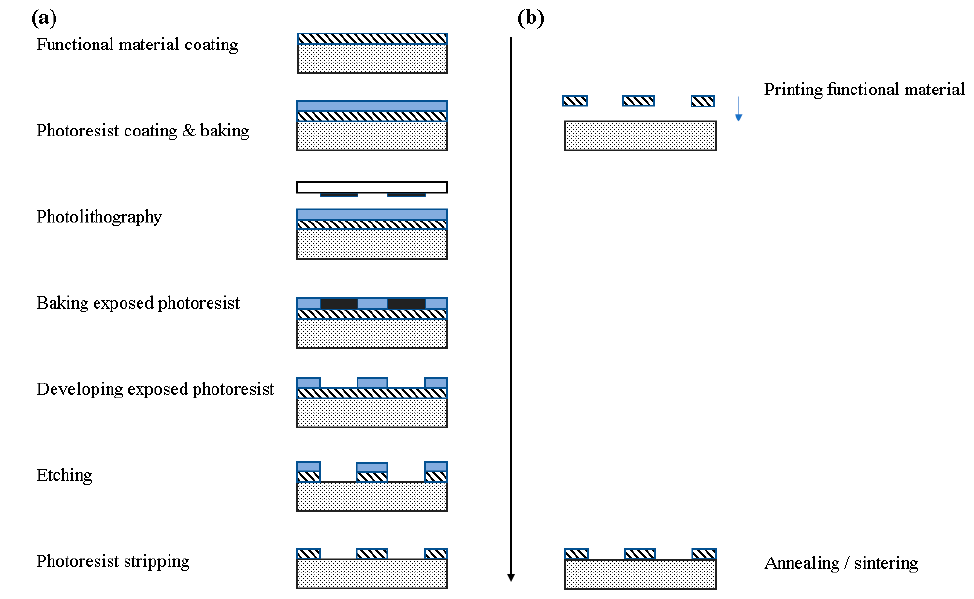
Figure 1. Comparison of Si-based manufacturing and printing process. ( a ) Traditional IC manufacturing; ( b ) printing process.